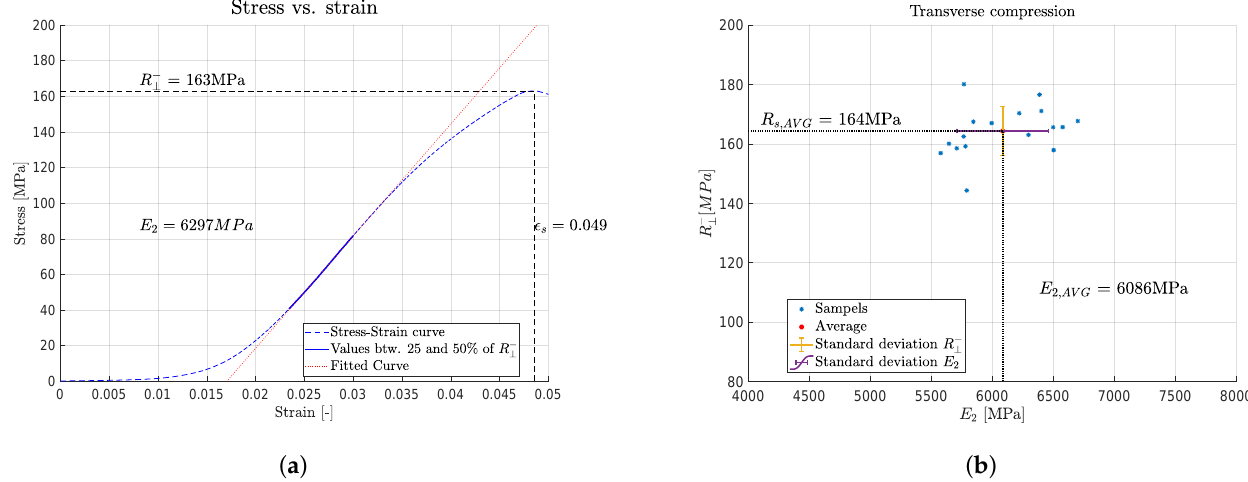
Figure 3. Transverse compression. ( a ) Typical stress–strain curve of one sample; ( b ) Scatter plot of 16 samples E 2 vs. R − ⊥